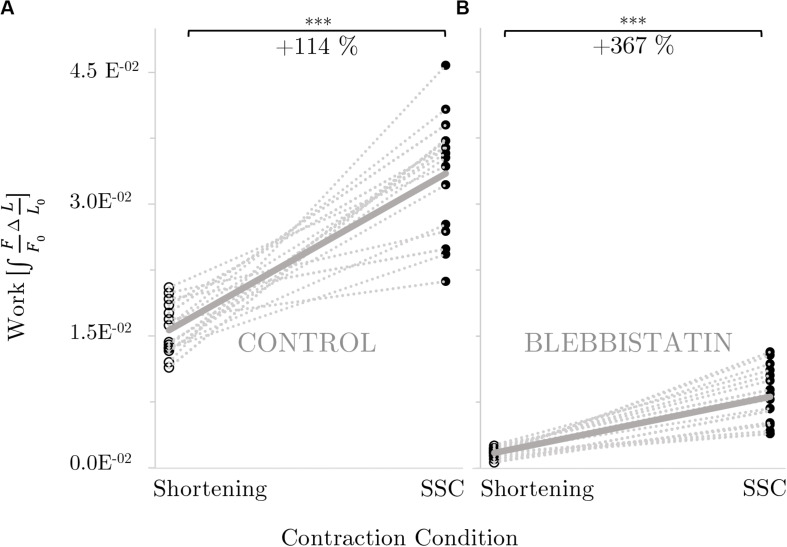
Influence of active shortening and SSC on work for (A) control and (B) Blebbistatin experiments. The gray dotted lines indicate the individual paired data values and the gray solid line indicates the mean value (n = 16). Work is shown in normalized values (∫FF⁢0ΔLL⁢0). Brackets and asterisks (*) mark differences in work obtained during active shortening [white circles] compared with stretch-shortening [SSC; black circles] conditions in the intergroup comparison. (B) Statistical analysis is based on muscle fiber experiments in the presence of Blebbistatin. Significance levels are marked as follows: *p < 0.05, **p < 0.01, and ***p < 0.001. ns means not significant.